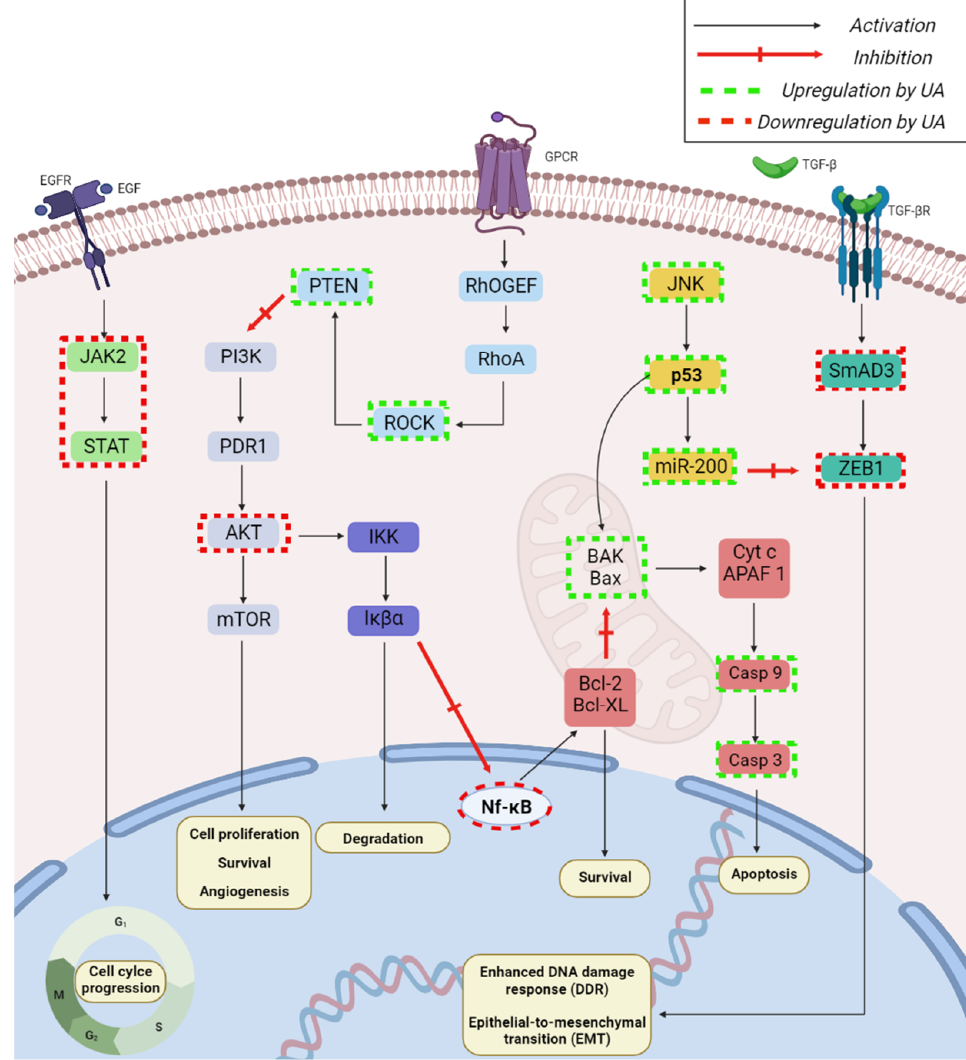
Figure 14. Schematic representation of the reported anticancer mechanisms of UA; key signaling pathways targeted by UA in cancer: PI3K/Akt signaling pathway inhibition -> inhibition of angiogenesis, cell survival, and proliferation; JNK signaling pathway activation-> induction of apoptosis; TGF-β1 pathway inhibition -> miR200a/b/c up-regulation -> induction of apoptosis; EGFR/JAFK2/STAT3 signaling pathway down-regulation -> G0/G1 cycle arrest -> apoptosis; ROCK1/PTEN/cytochrome c signaling pathway down-regulation-> activation of caspases -> induction of apoptosis; IKK/NF-kB pathway down-regulation -> G0/G1 cycle arrest -> apoptosis. Created with BioRender.com (accessed on 8 May 2022).